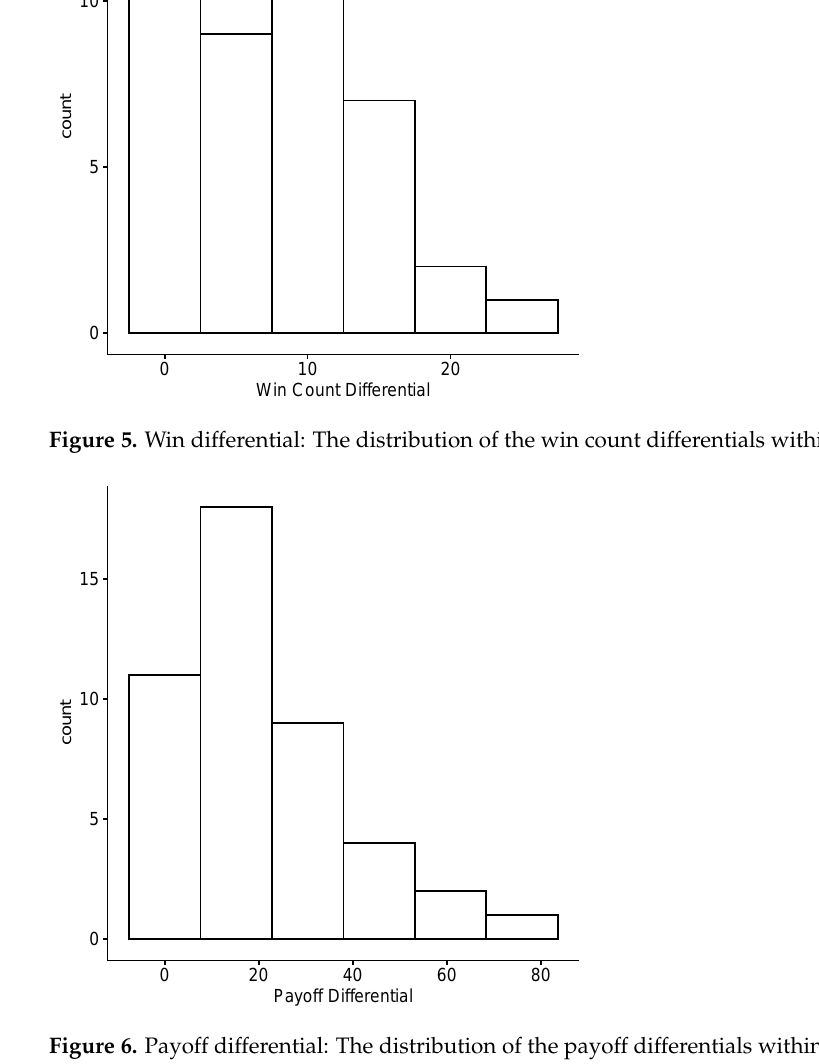
Figure 6. Payoff differential: The distribution of the payoff differentials within a